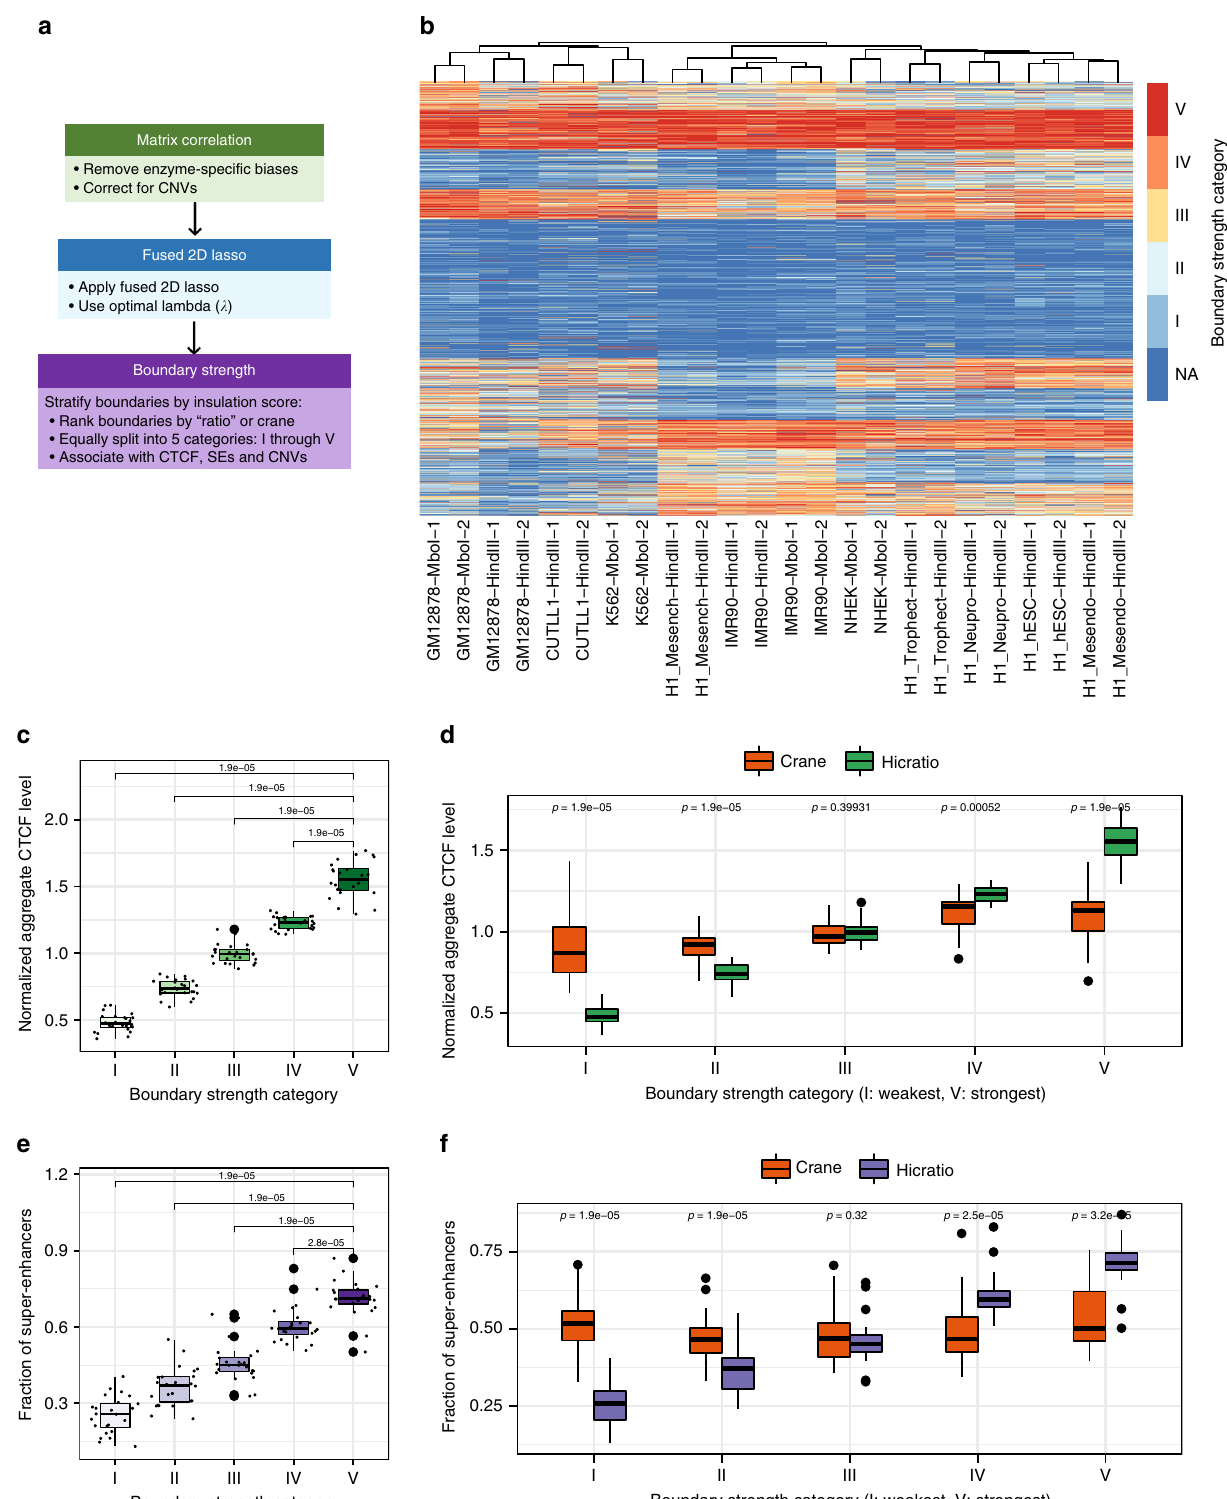
Boundary strength category (I: weakest, V: